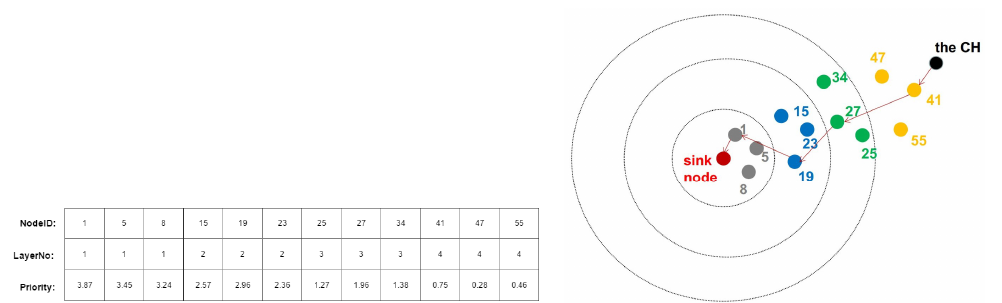
Figure 6. An example of hierarchical priorities initialization for part b and its corresponding topological routing path in the cross-section